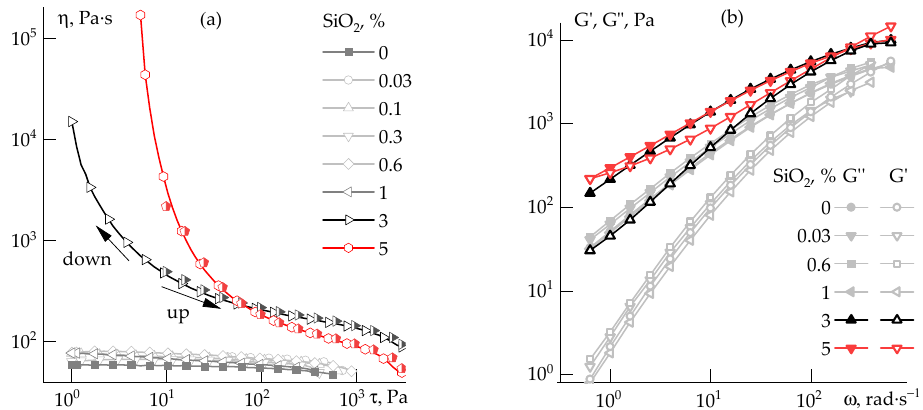
Figure 8. Flow curves at shear rate increase to 1000 s − 1 followed by decrease in it ( a ), and frequency dependences of elastic and loss moduli ( b ) for 20 wt% PAN solutions with various silica content. Silica concentration is at the solution weight. Table 2. Slopes’ values for 20 wt% PAN solutions filled silica. Silica concentration is at the solution weight. SiO 2 , %wt